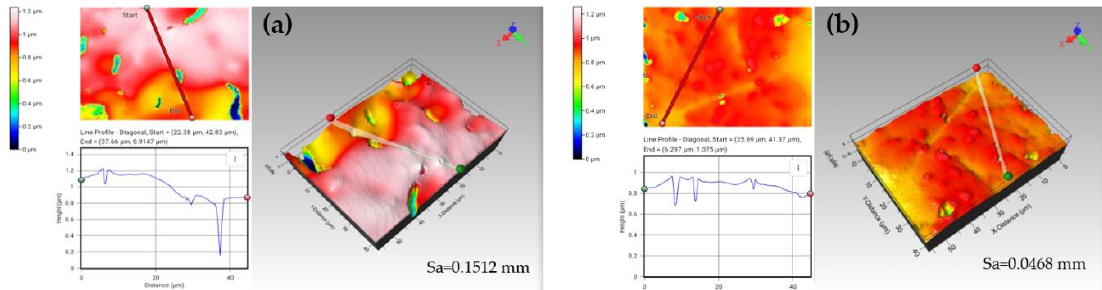
Figure 6. Optical profilometry images showing the bidimensional (2D) and tridimensional (3D) surface morphologies of ( a ) Alg-Patch and ( b ) Alg-St- Patch, the respective pore depth profiles, and roughness profile parameters.